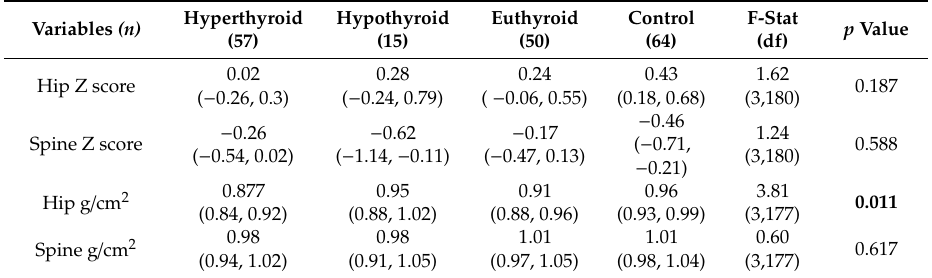
Table 14. ANCOVA analysis adjusts for age and gender. Comparisons of the Z score mean for hip and spine and bone density (g / cm 2 ) for hip and spine in between